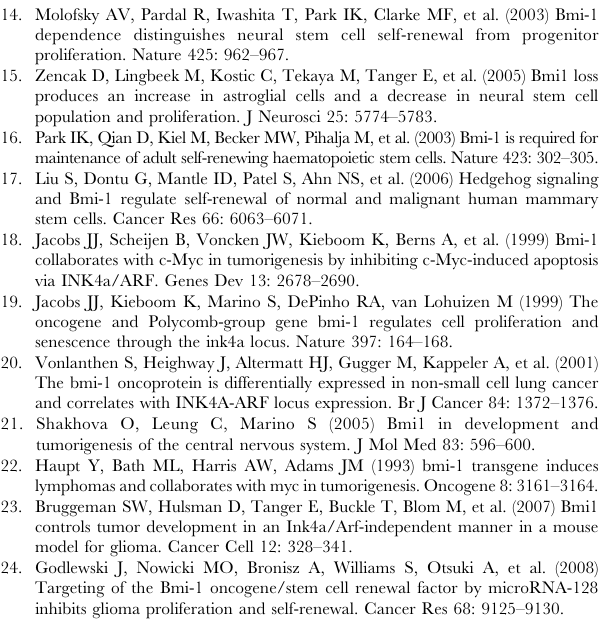
Figure S3 GSK3 inhibition induces differentiation of the BS287